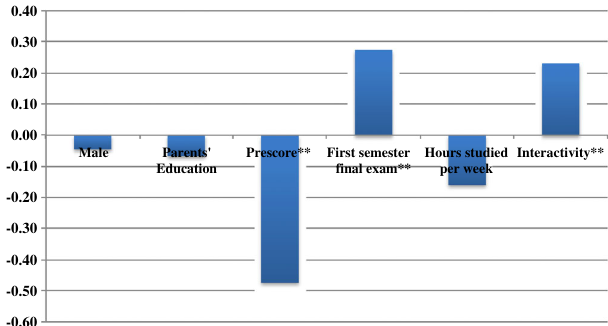
FIG. 1 (color online). Standardized coefficients for model 3 with FCI Newton’s third law gain as the dependent variable (from Table III) (* p < 0 : 05 , ** p < 0 : 01